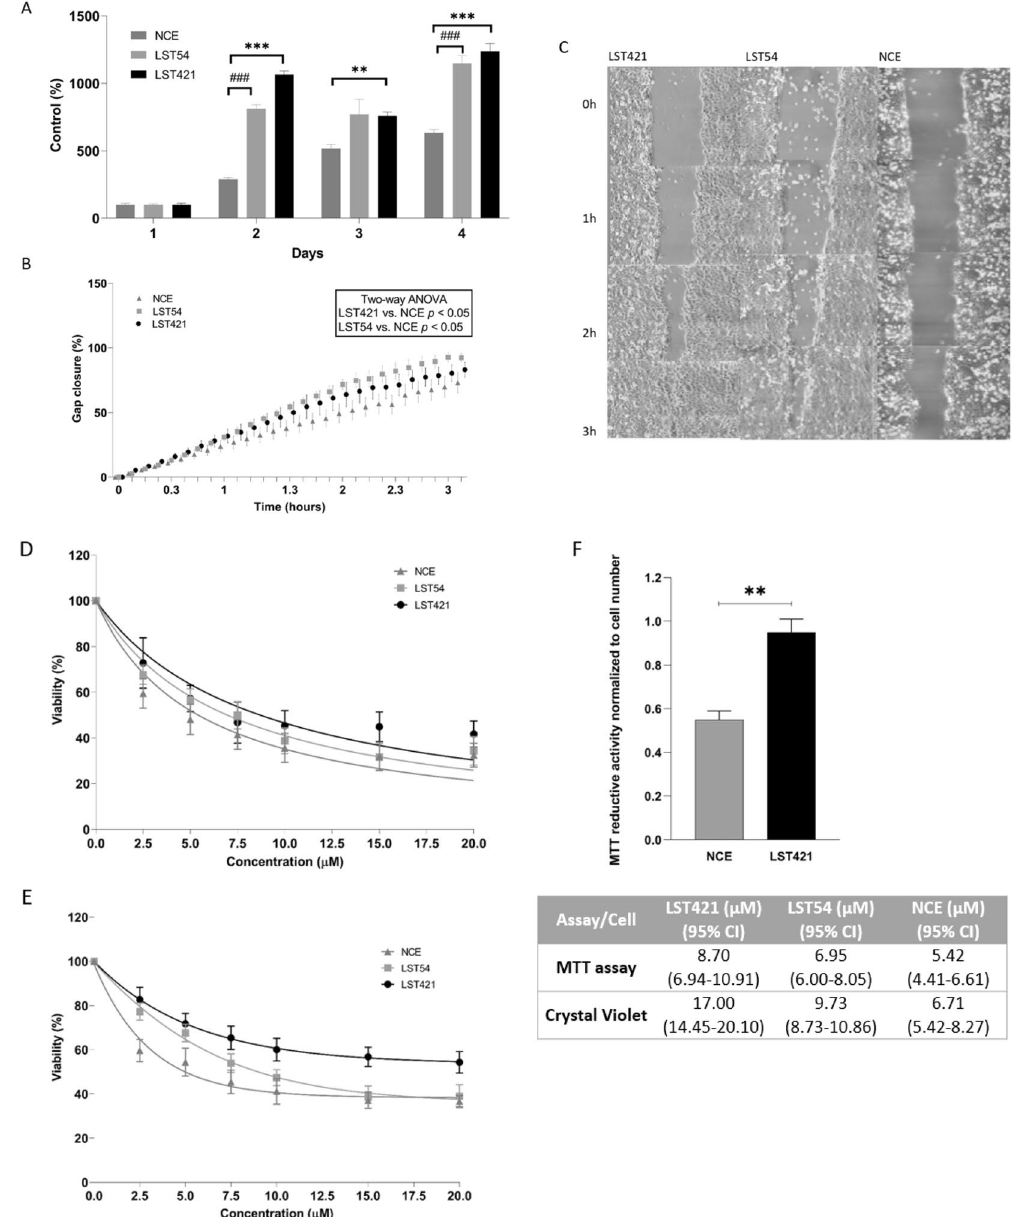
Figure 2. Cytoglobin expression increases cell growth and motility. ( A ) Cell number in culture following plating at the same density, ( B , C ) increased in cell motility as assessed by the wound healing assay and quantification using an In cell analyser. The results represent the mean of three experiments carried out in duplicate ± SD (n = 3). *** ( p < 0.001) and ** ( p < 0.01) represent t-test statistical significant difference between LST421 and NCE cells. ### ( p < 0.001) represents t-test statistical significant differences between LST54 and NCE cells. Two-way ANOVA shown in B appear inset. Cytoglobin expression protects cells from cisplatin- induced cytotoxicity. Cells were treated with cisplatin 0–20 µM cisplatin for 24 h. ( D ) Cell viability as assessed by the MTT assay (line represents non-linear least squares regression analysis of normalised response data), ( E ) Cell viability as assessed by the crystal violet assay (line represents non-linear least squares regression analysis of normalised response data) and F ) MTT assay normalised to cell number. Inset table contains IC 50 values as determined using both the MTT and Crystal Violet assay calculated using least squares non-linear regression analysis. The results represent the mean of three experiments carried out in duplicate ± SD (n = 3). ** Significantly differently from un-transfected parent cell line, p <